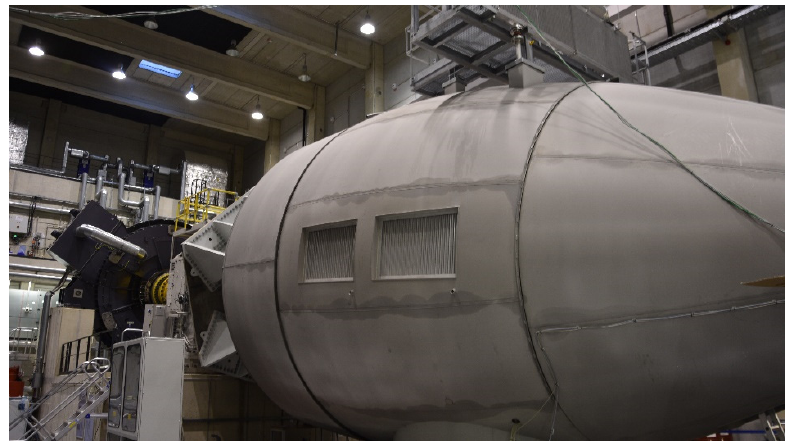
Figure 1. State-of-the-art multi-megawatt nacelle test bench at the Center for Wind Power Drives, RWTH Aachen University, with an ENERCON E-115 E2 mounted.